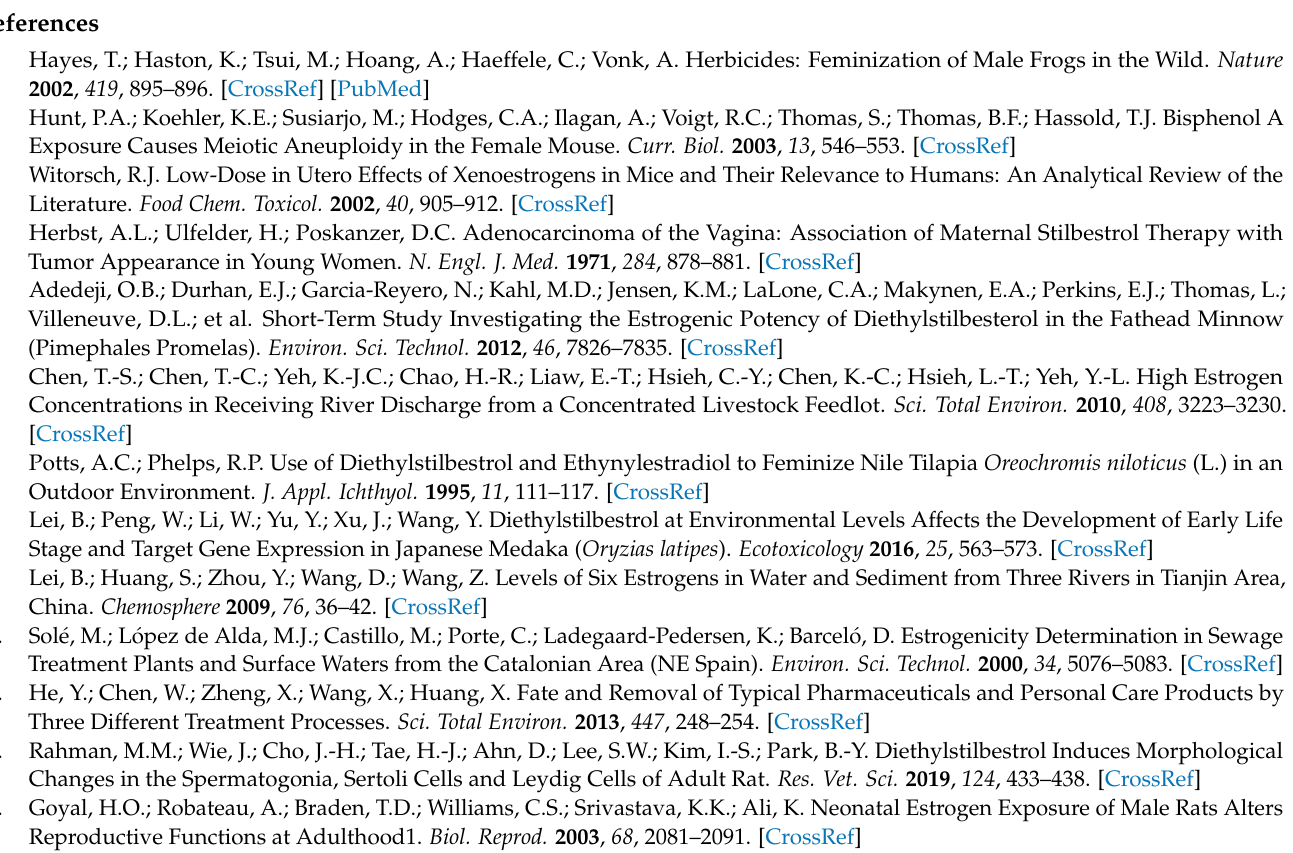
Figure A1. Different stages of DES exposure: ( a ) zebrafish exposed to DES from 10 to 25 dpf, which is initial development stage (IDS); ( b ) zebrafish exposed to DES from 25 to 45 dpf, which is gonadal differentiation stage (GDS); ( c ) zebrafish exposed to DES from 45 to 60 dpf, which is gonadal maturity stage (GMS); ( d ) zebrafish exposed to 0.01% acetone. We only exposed zebrafish at IDS, GDS, and GMS, individually, and maintained them in freshwater for 90 dpf after exposure phase.